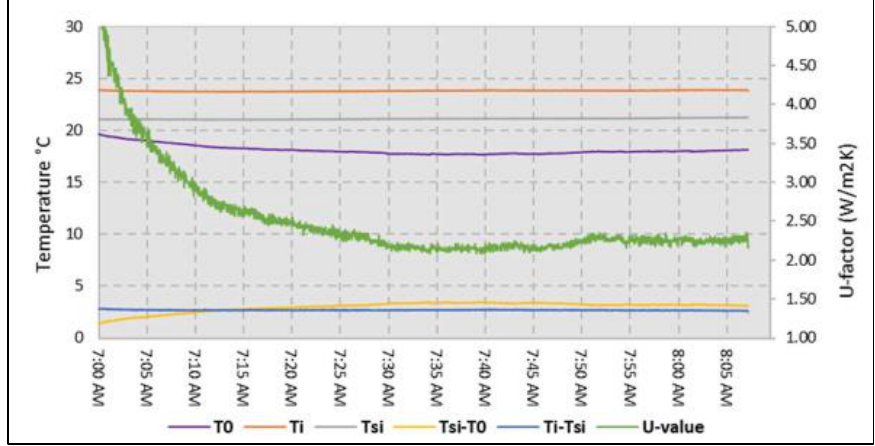
Figure 21. Third Measurement [32].